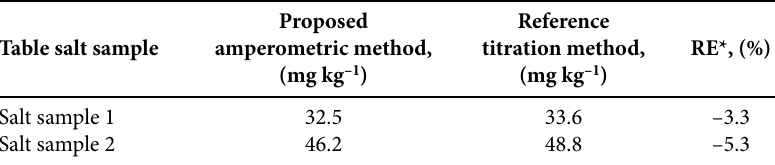
Table 4. Iodate content in iodized table salt samples determined by different methods. Proposed Table salt sample amperometric method, titration